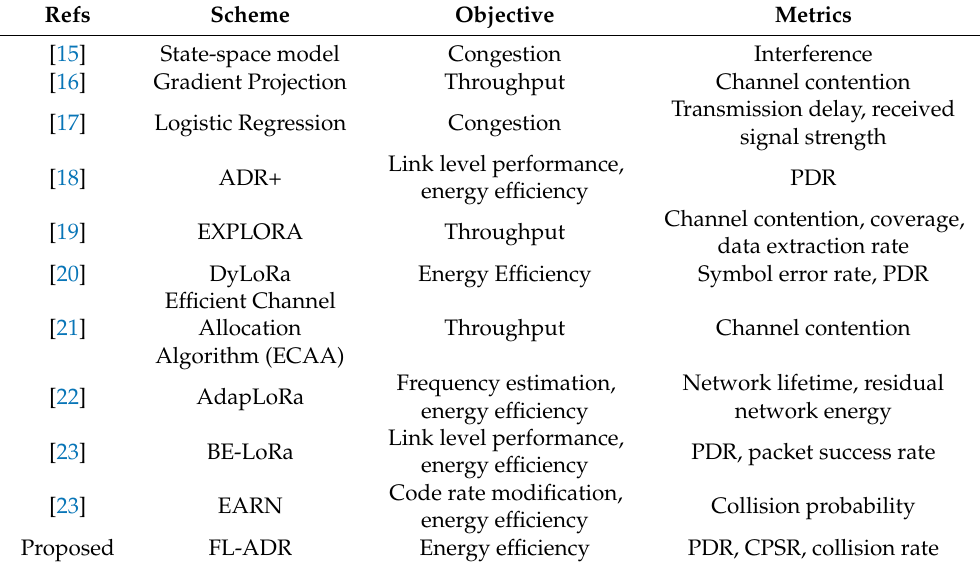
Table 1. Summary of related